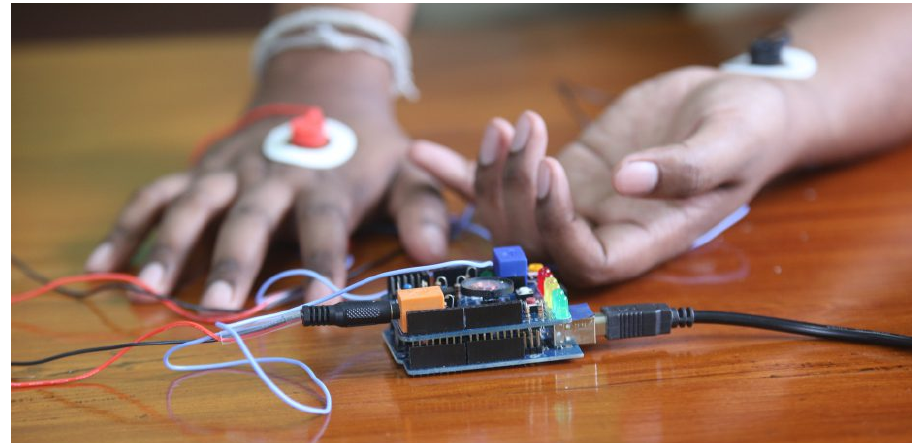
Figure 1. SpikerShield Heart and Brain sensor.